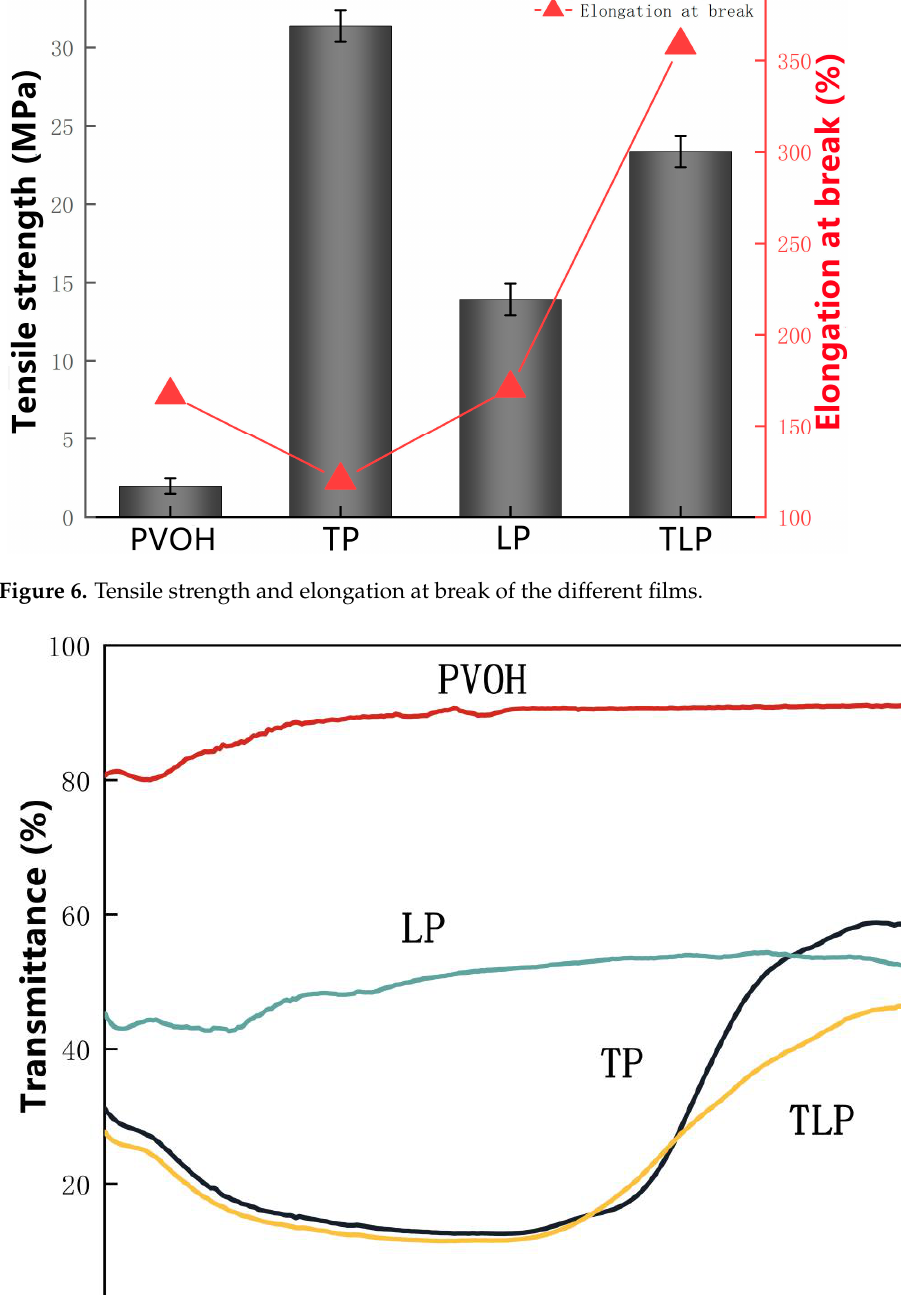
Figure 7. Ultraviolet-visible (UV- VL ) transmittance of the various films.